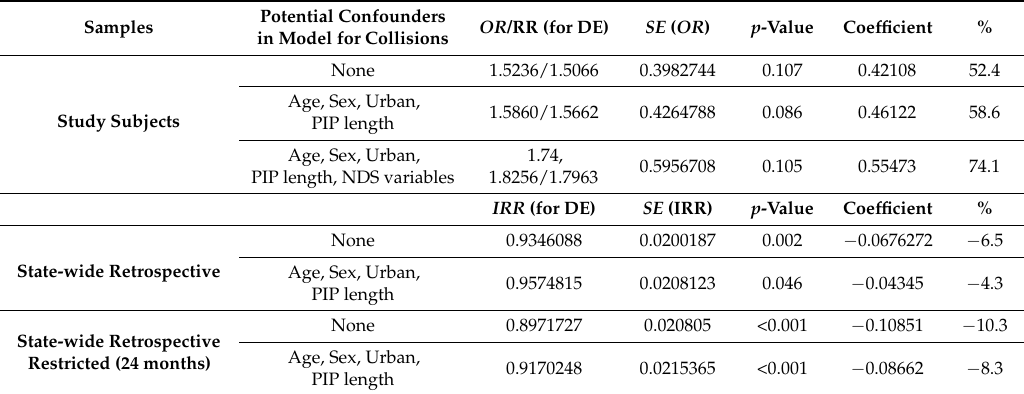
Table 5. Influence of Confounding Factors on Collisions. RR : risk rate; and IRR : incidence rate ratio. Samples